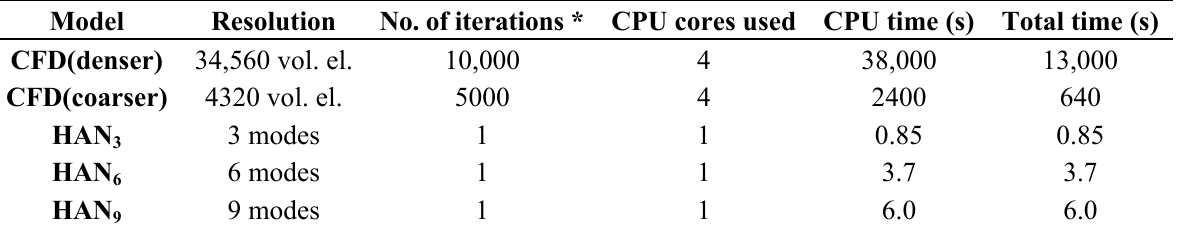
Table 3. Calculation times (on a desktop